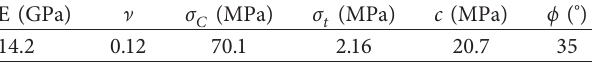
Table 2: Mechanical properties of the cast mortar.